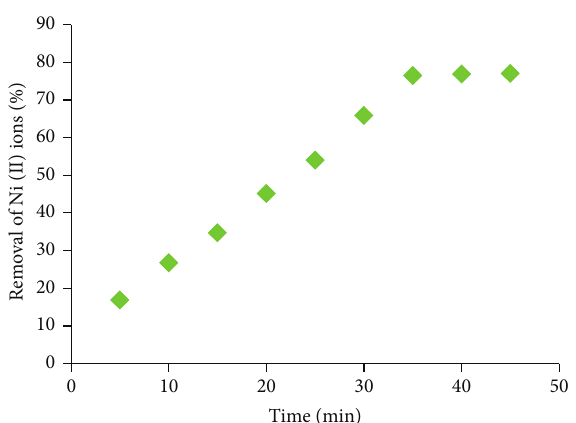
Figure 8: Effect of adsorbent dose on the adsorption of Ni (II) ions by